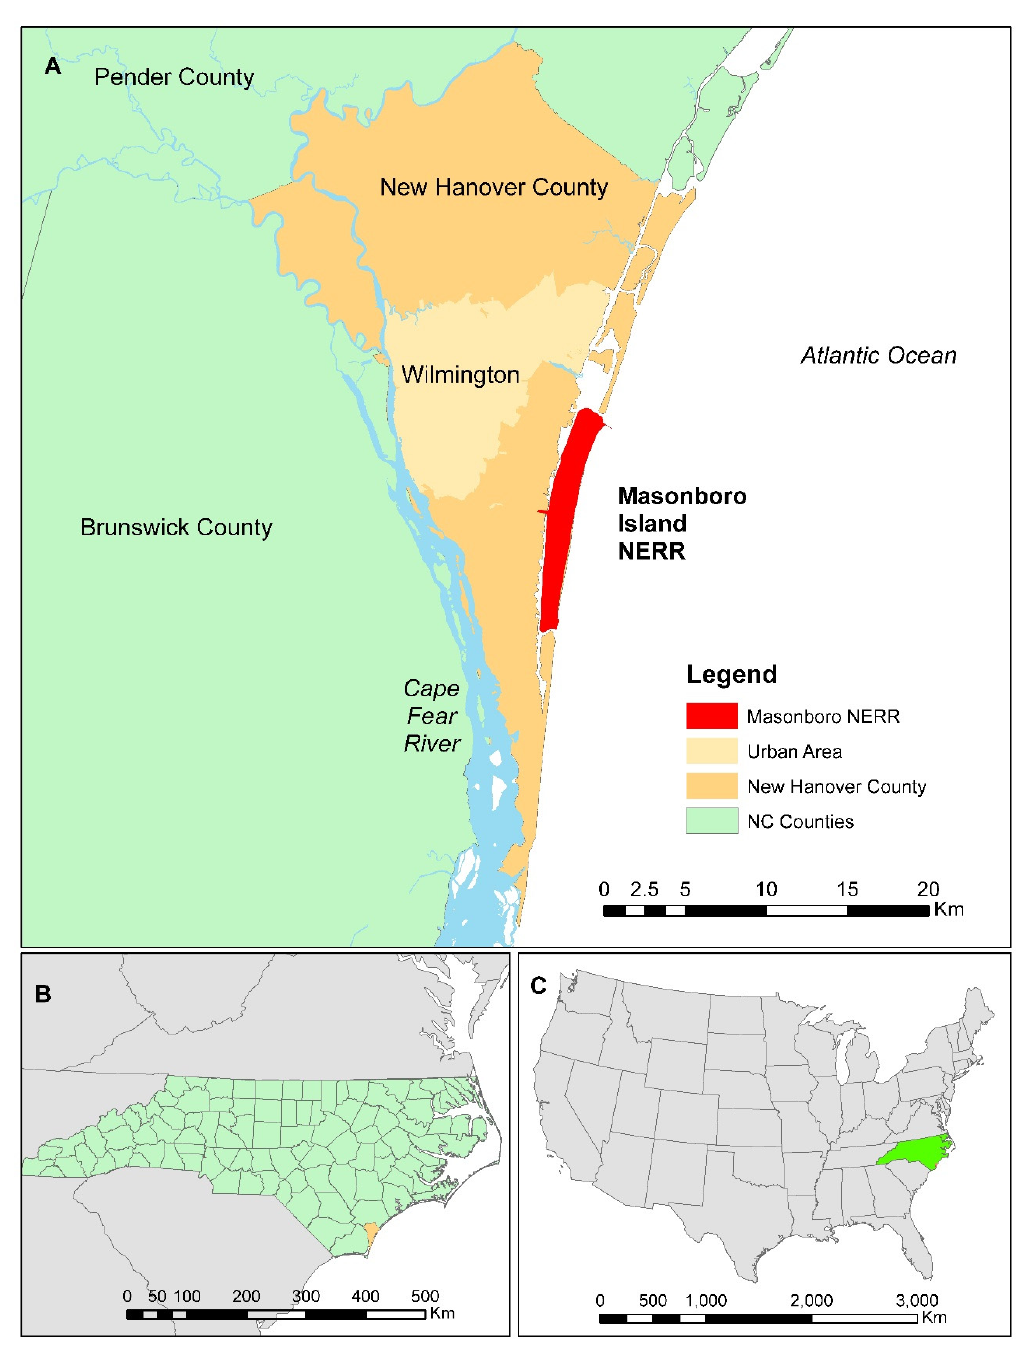
Figure 1. The Masonboro Island Reserve is located in ( A ) New Hanover County, in ( B ) Southeastern North Carolina, and in the ( C ) Southeastern United States.